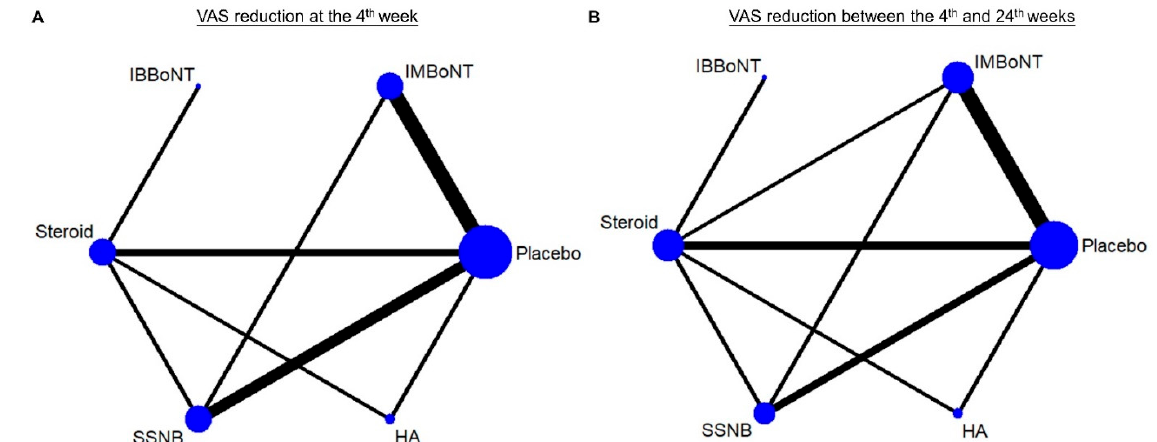
Figure 3. Network plots of injection therapies in terms of the VAS reduction ( A ) at the 4th week and ( B ) between the 4th and 24th weeks. The nodes indicate the types of injections being compared and the edges indicate available direct comparisons between pairs of treatments. BoNT, botulinum toxin; HA, hyaluronic acid; IB, intra-bursal; IM, intra-muscular; SSNB, suprascapular nerve block; VAS, visual analogue scale.